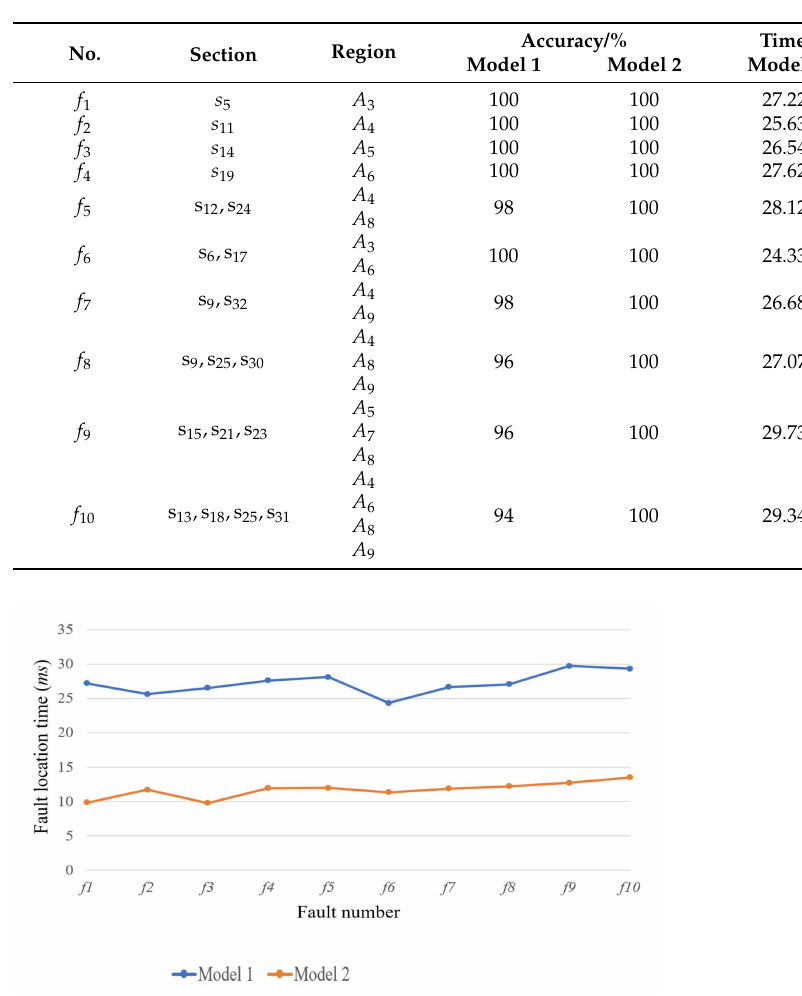
Figure 10. Distribution network regionalization simulation model. Table 11. Fault location results under different simulation models.